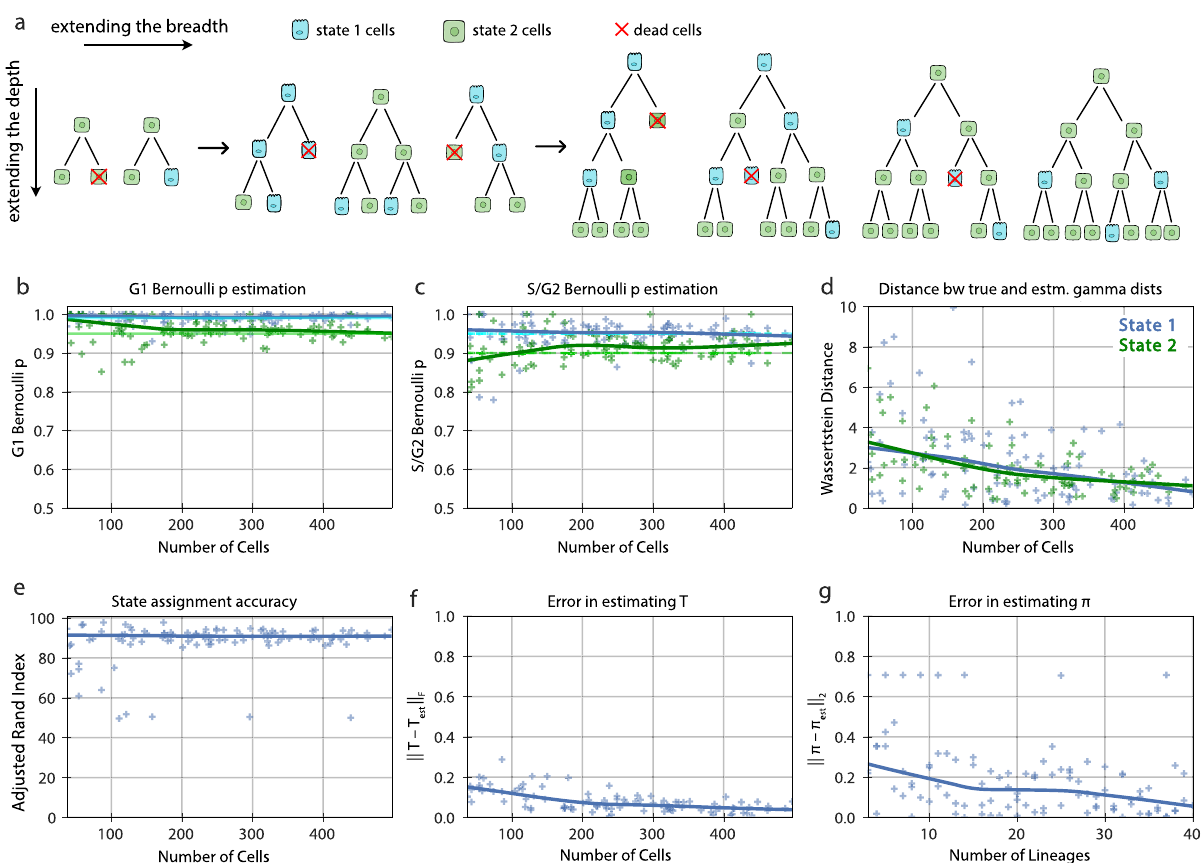
Fig. 4 Model performance on censored lineages of two states with increasing breadth and depth. a Synthetic two-state populations of increasing breadth (increasing number of initial cells and therefore lineages) and of increasing depth (increasing experiment time and therefore more cells in each lineage) are analyzed. The states are shown as green and blue colors. Red indicates cell death. b , c The accuracy of estimating the Bernoulli parameters for G1 and S/G2 phase, respectively. Each point in the scatter plots represents the inferred value for a model evaluation trial with the number of cells shown in the x-axis. The dark solid lines are the Lowess trendline across the individual trials. The light green and light blue lines show the true value of the parameters. d The distance between the true and estimated gamma distributions associated with phase lengths for the two states. e The state assignment accuracy. f The errors in the estimated and transition rate matrices. g The initial probability vector. Note that the Wasserstein distance between the true and estimated distributions for each state is much lower than the distance between two distributions that are quite similar (Fig. 5b). 100 simulation trials are